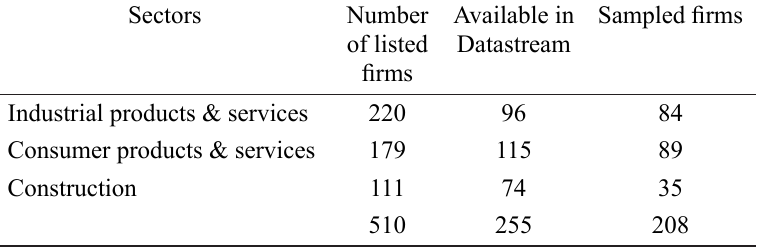
Available in Sampled firms of listed Datastream firms